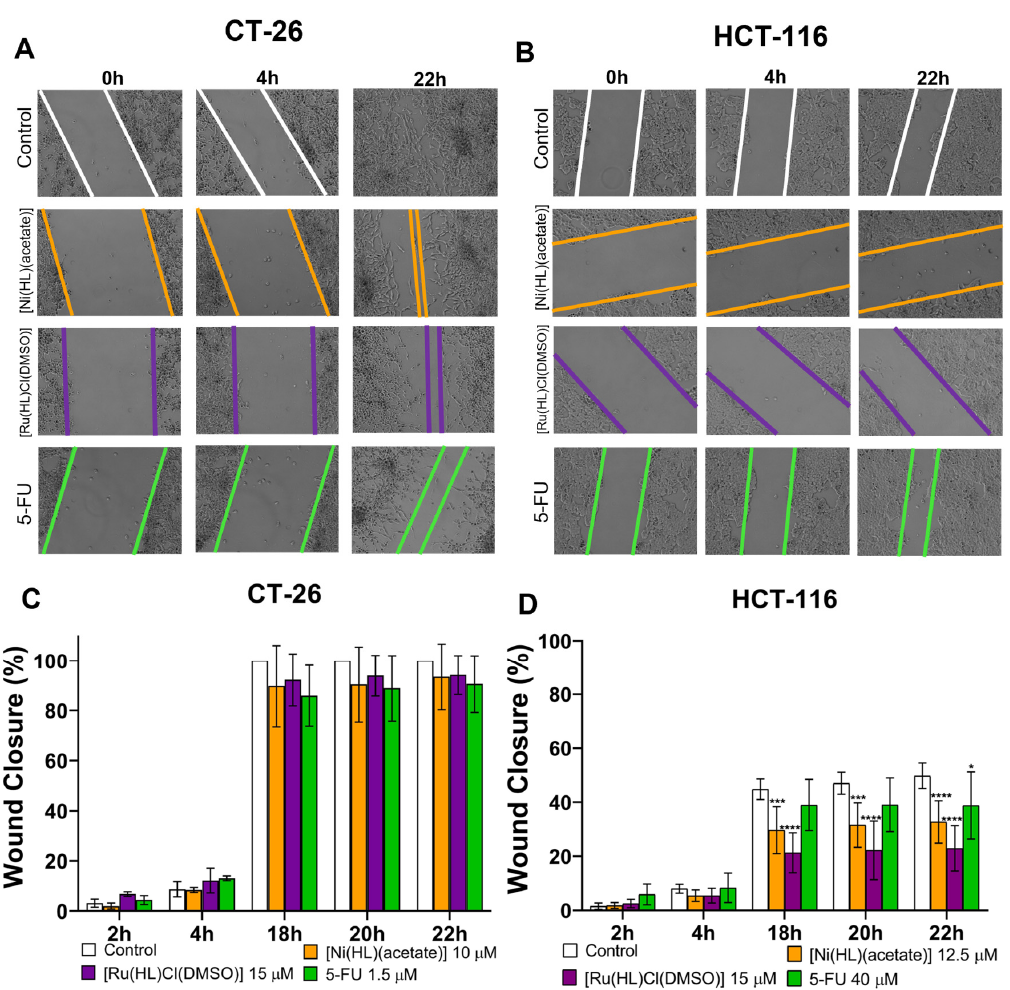
Figure 11. Representative images of CT-26 ( A ) and HCT-116 ( B ) cell migration in the absence (negative control) or presence of [Ni(HL)(acetate)], [Ru(HL)Cl(DMSO)] and 5-FU (positive control) at fixed time periods. Wound closure progression (%) of CT-26 ( C ) and HCT-116 ( D ) cells. Data are expressed as mean ± SD of two independent experiments. * p < 0.05, *** p < 0.001, **** p < 0.0001 vs. control. Statistical analysis was performed by two-way ANOVA with Dunnett’s test.